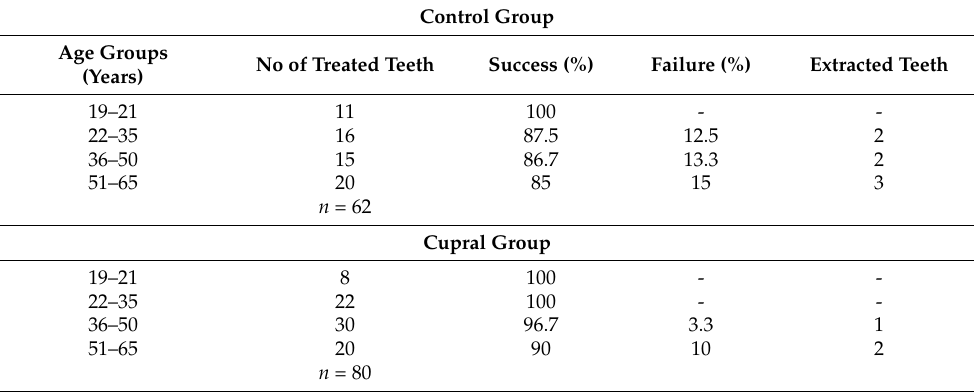
Table 1. Outcome after an 18-month survey in the control and Cupral